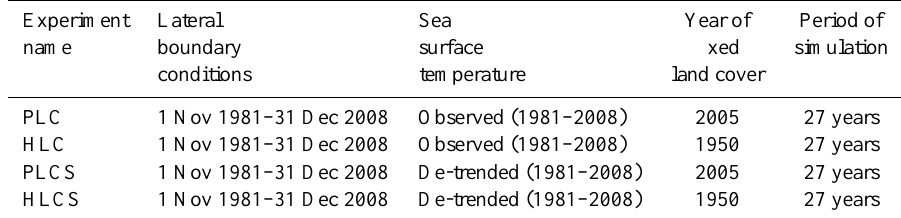
Table 1. Experimental setup for LULCC-based simulations with